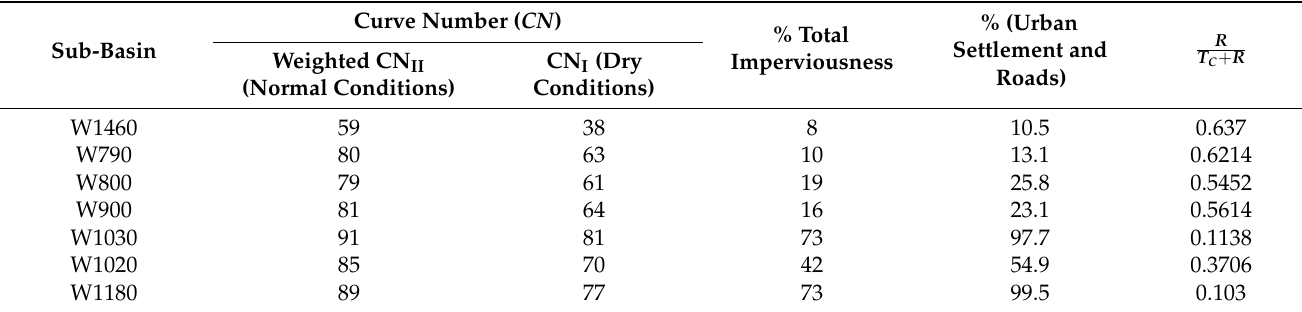
Table 4. Summary of the Humber sub-basins’ important variables.